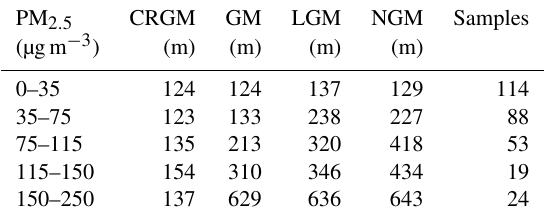
Table 2. Root mean square error (RMSE) for each lidar retrieval method compared with radiosonde measurements and sample size in each comparison